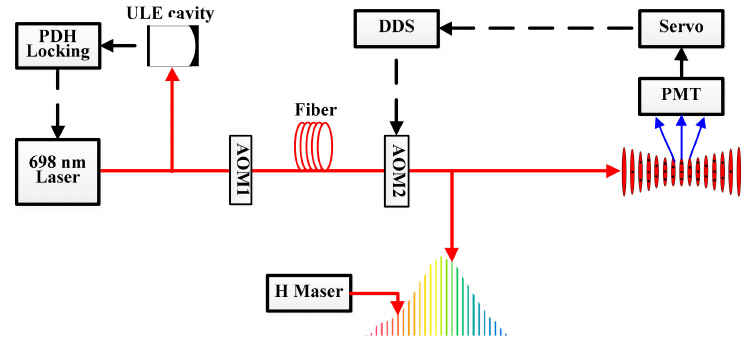
Figure 6. Schematic diagram of the experimental setup for 87 Sr optical lattice clock. (DDS: direct digital synthesizer; PMT: photomultiplier tube; PDH: